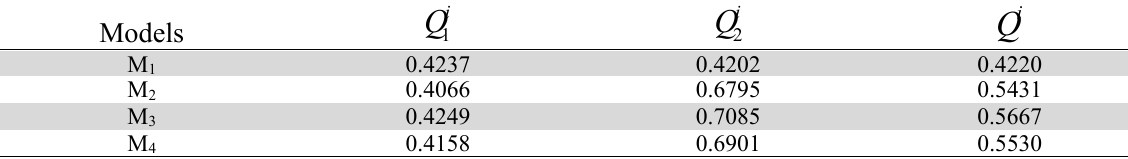
WASPAS results for the mini-grid business models